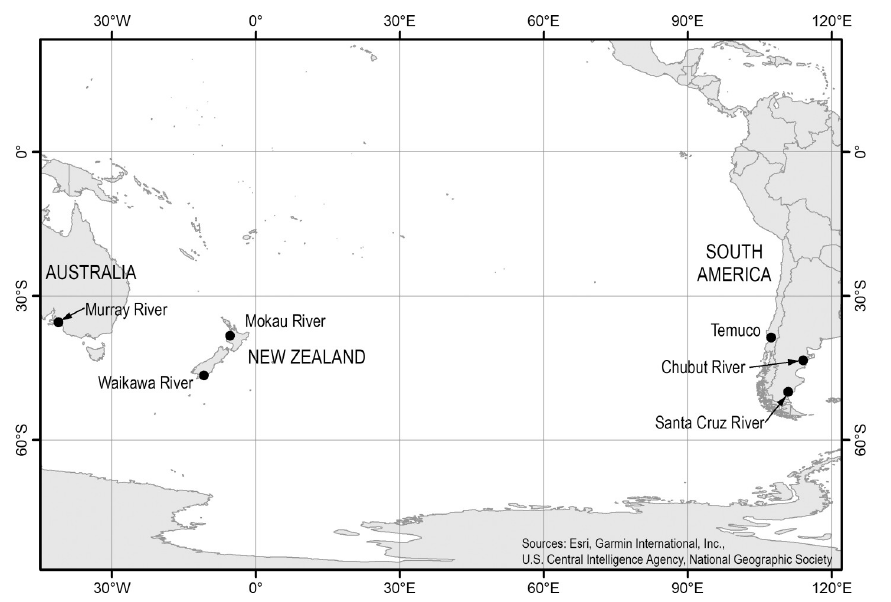
Fig 1. Location of sampling sites in Australia (Murray River), New Zealand (Mokau and Waikawa rivers), Argentina (Chubut and Santa Cruz rivers) and Chile (Temuco). Fig 1 was created using ArcGIS 10.6 based on our own collection sites, geographic information and shapefiles available at NIWA and geographic resources freely available online: